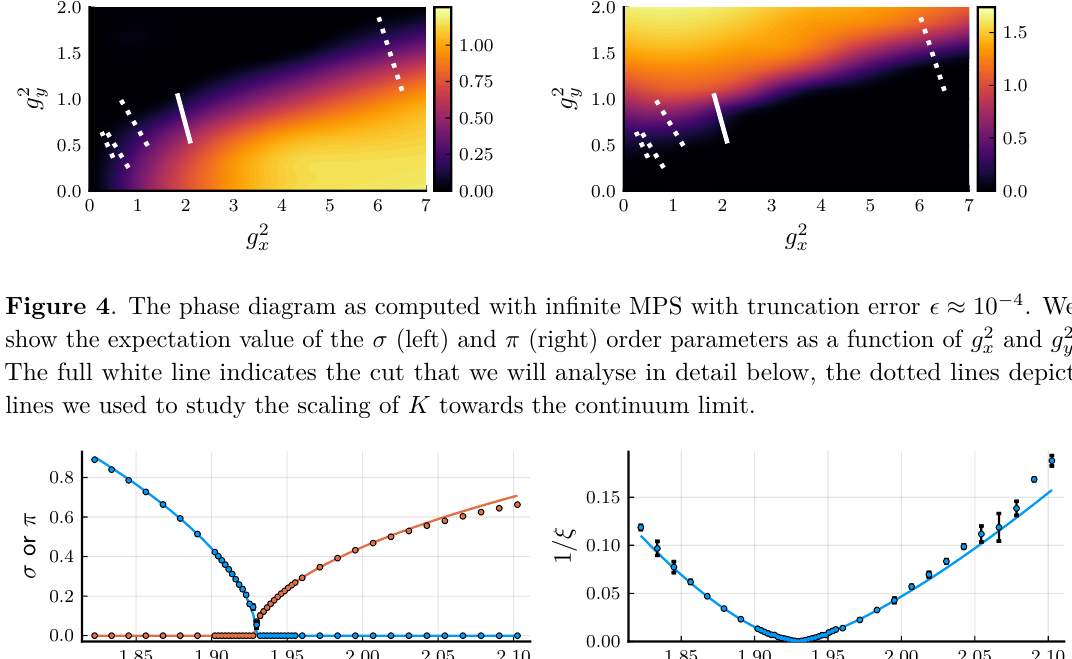
= 0 . 77 − 1 . 94( g 2 − 1 . 96) . (Right) y x